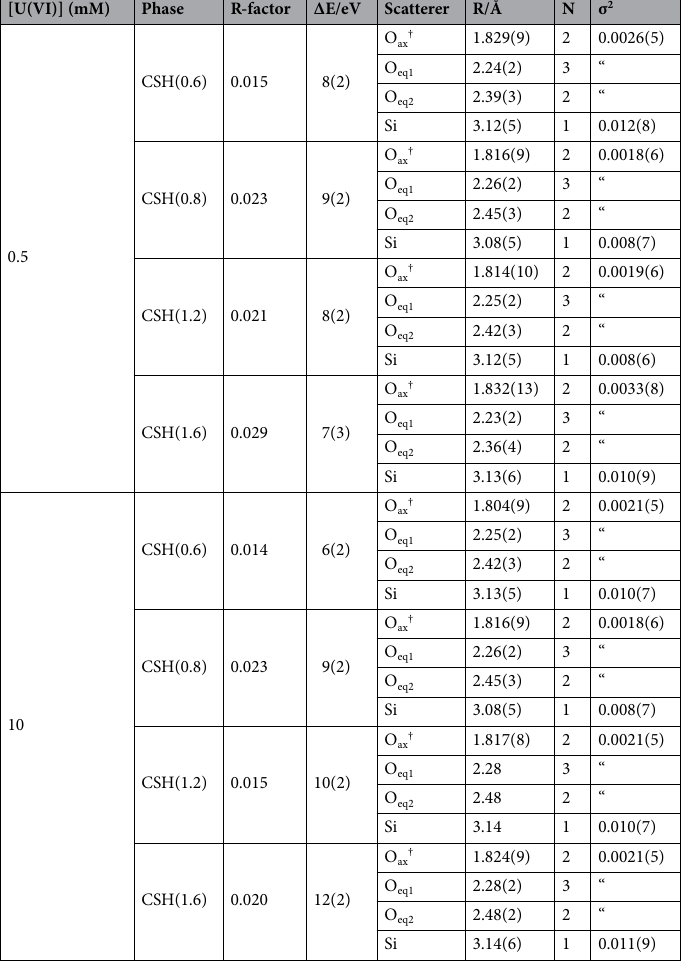
Table 2. EXAFS model parameters for U(VI)-contacted C–S–H minerals. R, effective interatomic distance; N, coordination number; σ 2 , Debye–Waller factor. Numbers with no errors have been fixed in the model. † MS pathways also fitted at twice the distance of R Oax